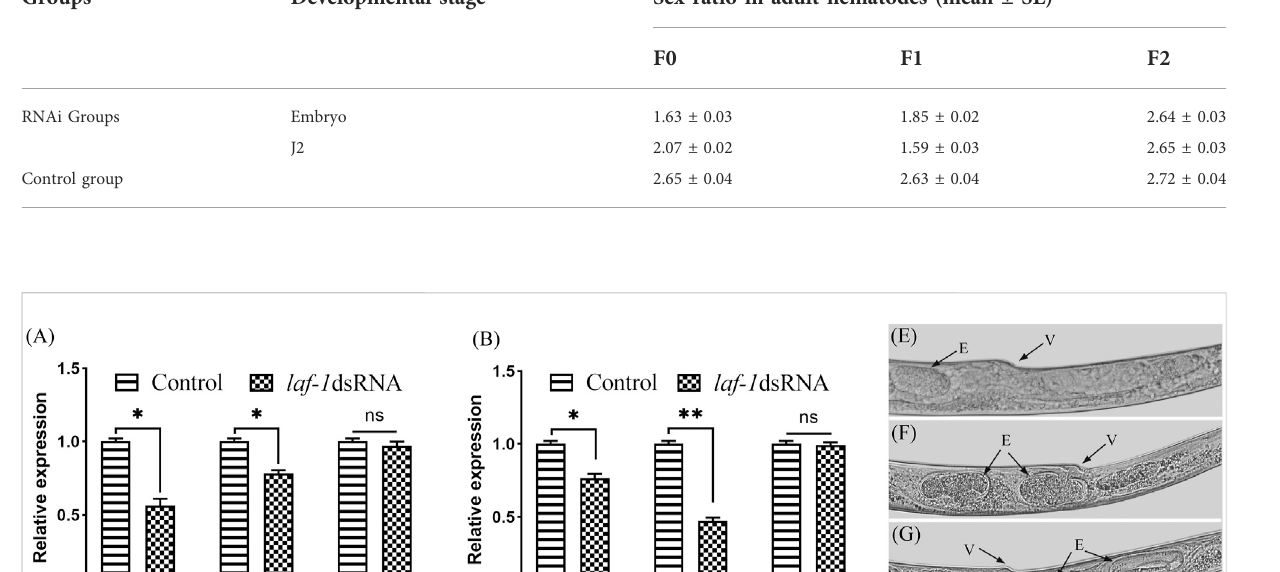
TABLE 2 The sex ratios in different groups of B.xylophilus .